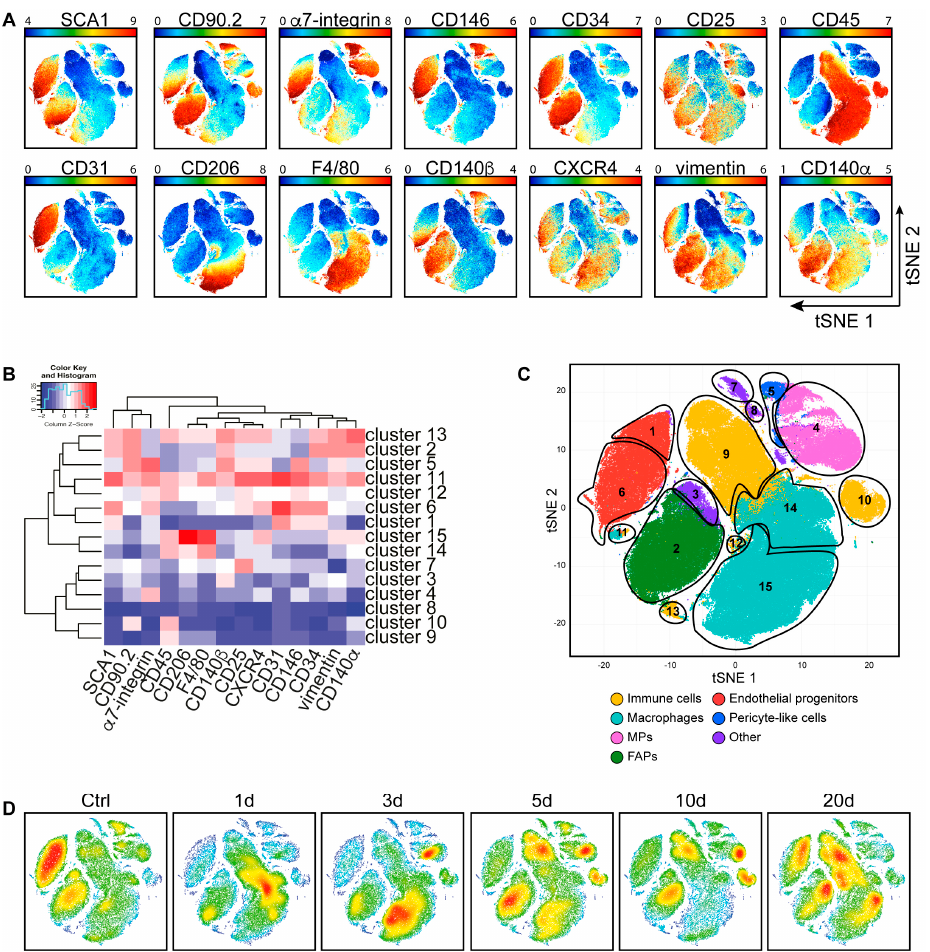
Figure 4. Identification of the main mdx skeletal muscle cell populations upon CTX-induced injury. ( A ) A mononuclear cell suspension was purified from uninjured and CTX-injured mdx hind limb muscles. The different samples were combined, barcoded, and analyzed to create a single t-SNE map colored according to SCA1, CD90.2, α 7-integrin, CD146, CD34, CD25, CD45, CD31, CD206, F4/80, CD140 β, CXCR4, vimentin, and CD140 α expression levels (blue: low expression; high expression of the selected marker). ( B ) FlowSOM heatmap of column normalized (Z-score) marker expression for each of the 15 clusters identified by Cytofkit analysis. Colors varied according to the expression level of each considered marker in a blue to red scale, indicating low and high expression, respectively. ( C ) Cell population clusters defined by overlapping the expression for each of the different analyzed antigens were projected onto t-SNE space and assigned to specific colors (yellow: immune cells; light blue: macrophages; pink: myogenic progenitors (MPs); dark green: fibro/adipogenic progenitors (FAPs); red: endothelial progenitors; blue: pericyte-like cells; purple: other). ( D ) Density plots colored by density (blue: low density; red: high density), showing cell abundance variations at different times during the regeneration process.